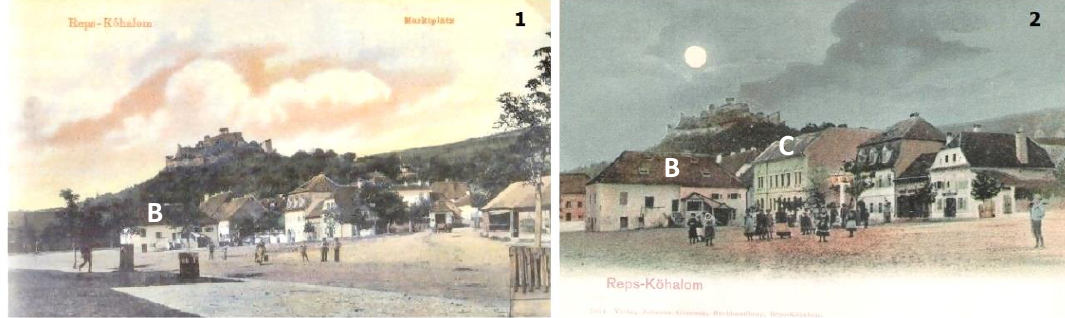
Figure 5: Postcards with view on Reps-Kőhalom during the Austro-Hungarian administration 1 – Postcard with a morning landscape, as suggested by the shadows on the ground, cca. 1900-1909, 2 – Postcard commemorating the first public gas lighting, approx. 1910 (Borcoman, 2010) The Personal Collection of Zoltan